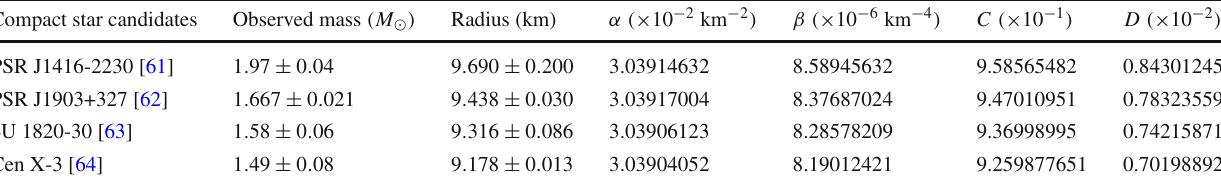
Table 1 Constant parameters calculated for radii and mass for some compact star candidates Compact star candidates